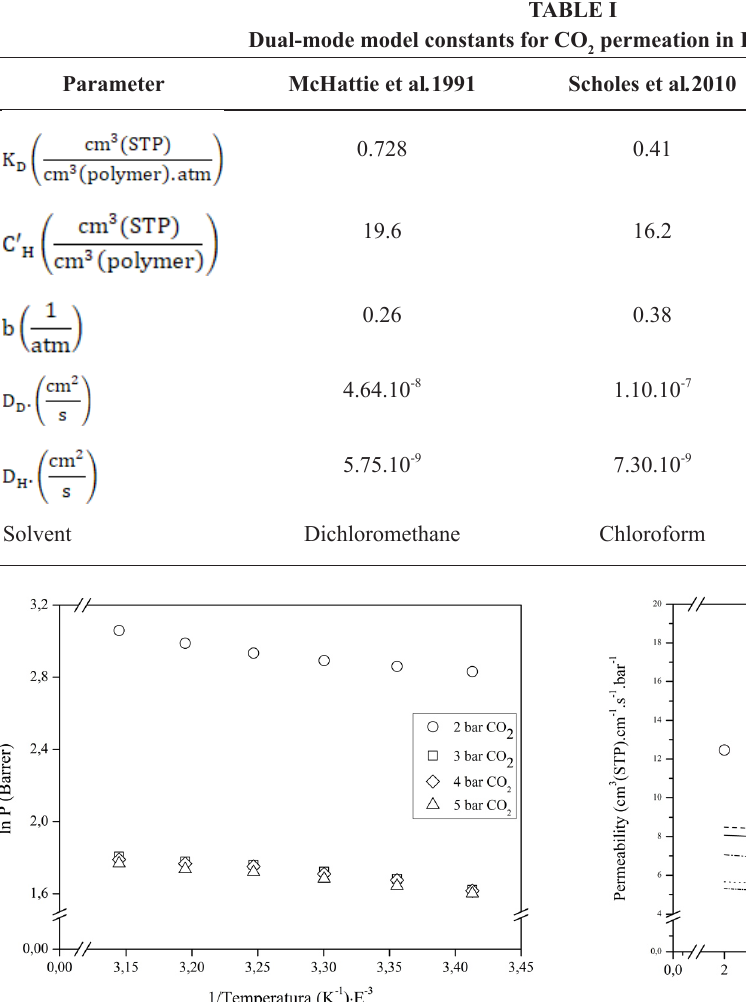
Dual-mode model constants for CO